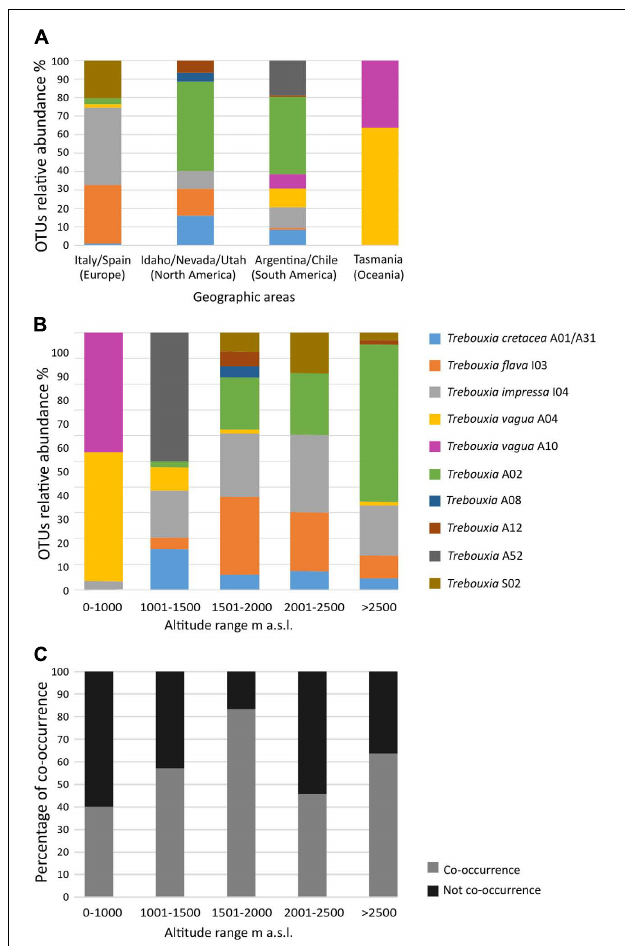
FIGURE 3 | Correlation of relative abundance of Trebouxia species-level lineages (OTUs) recovered in thalli of Rhizoplaca melanophthalma and Tephromela atra (A) with the geographic areas according to the continents ( Table 1 ), (B) with the altitudinal ranges (m a.s.l.) at which the lichen samples were collected ( Table 1 ). (C) Percentage of intrathalline co-occurrence of two or more Trebouxia species-level lineages in both R. melanophthalma and T. atra in relation to the altitudinal